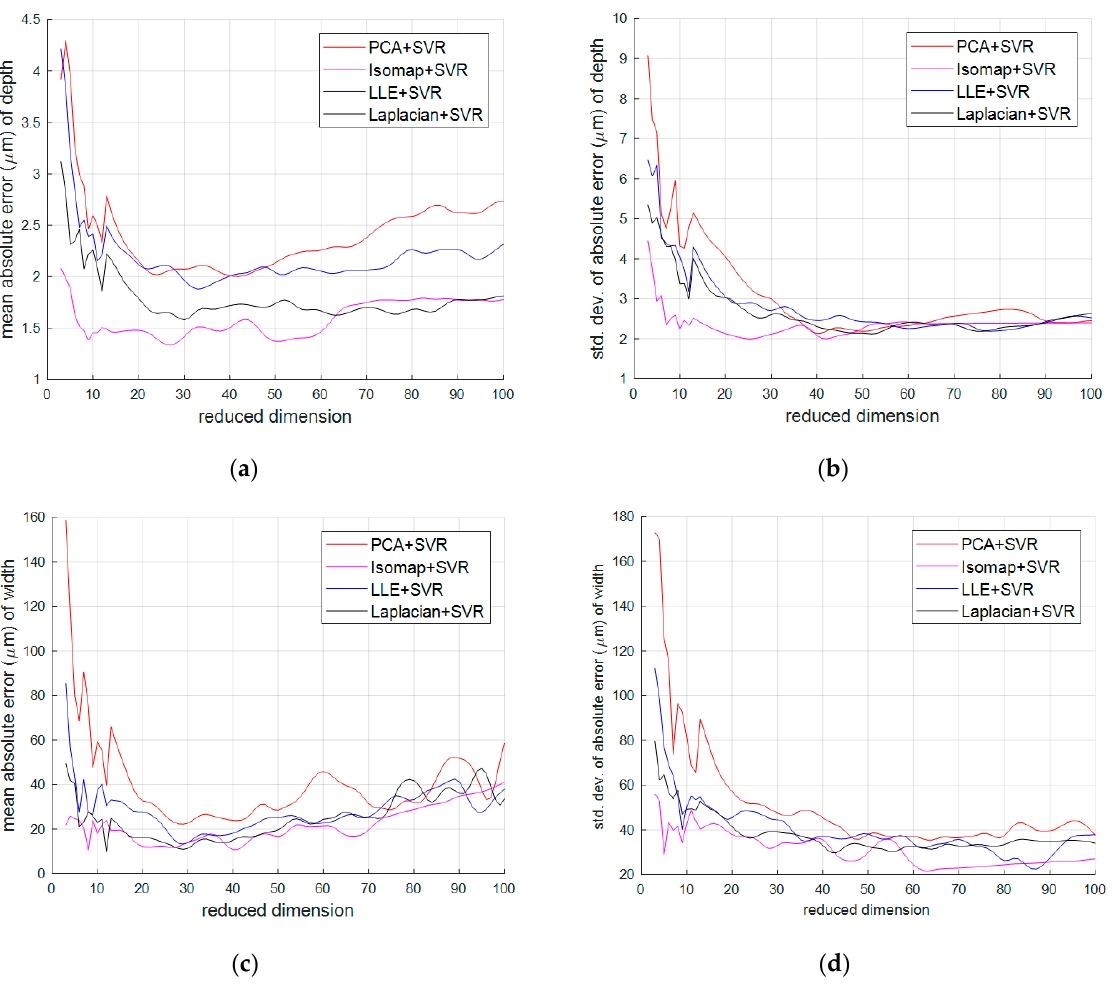
Figure 10. The mean absolute error (MAE) and the standard deviation of absolute error (SAE) performance comparison for defect depth and width estimation. ( a ) Depth estimation MAE vs. dimension number, ( b ) depth estimation SAE vs. dimension number, ( c ) width estimation MAE vs. dimension number, ( d ) width estimation SAE vs. dimension number.